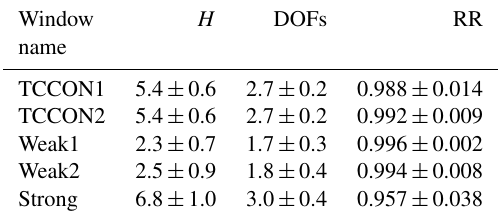
Table 5. Shannon information content ( H ), degrees of freedom for signal (DOFs) for the CO 2 profile, and ratio of residuals (RR) aver- aged over all 492 profile retrievals from near-infrared TCCON spec- tra measured at Lamont and coincident within ± 1h of the AirCore last sampling time. The standard deviation is also